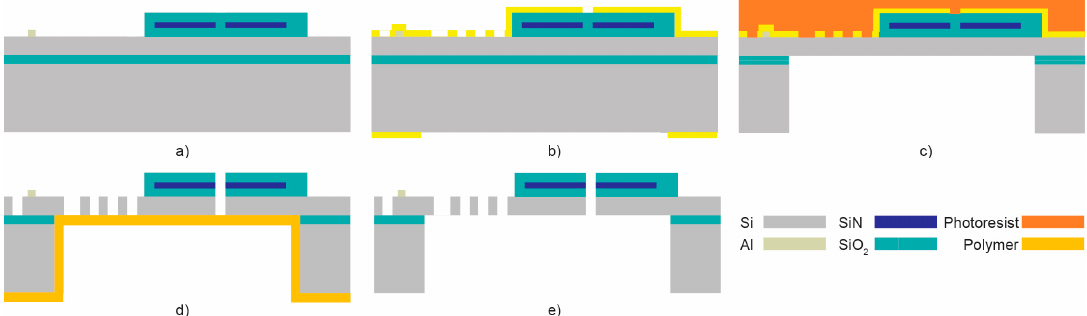
Figure 15. Simplified process flow ( a ) silicon-on-insulator (SOI) with patterned waveguides and Al pads, ( b ) front and back patterned Cr mask, ( c ) front protective layer and backside etch, ( d ) backside